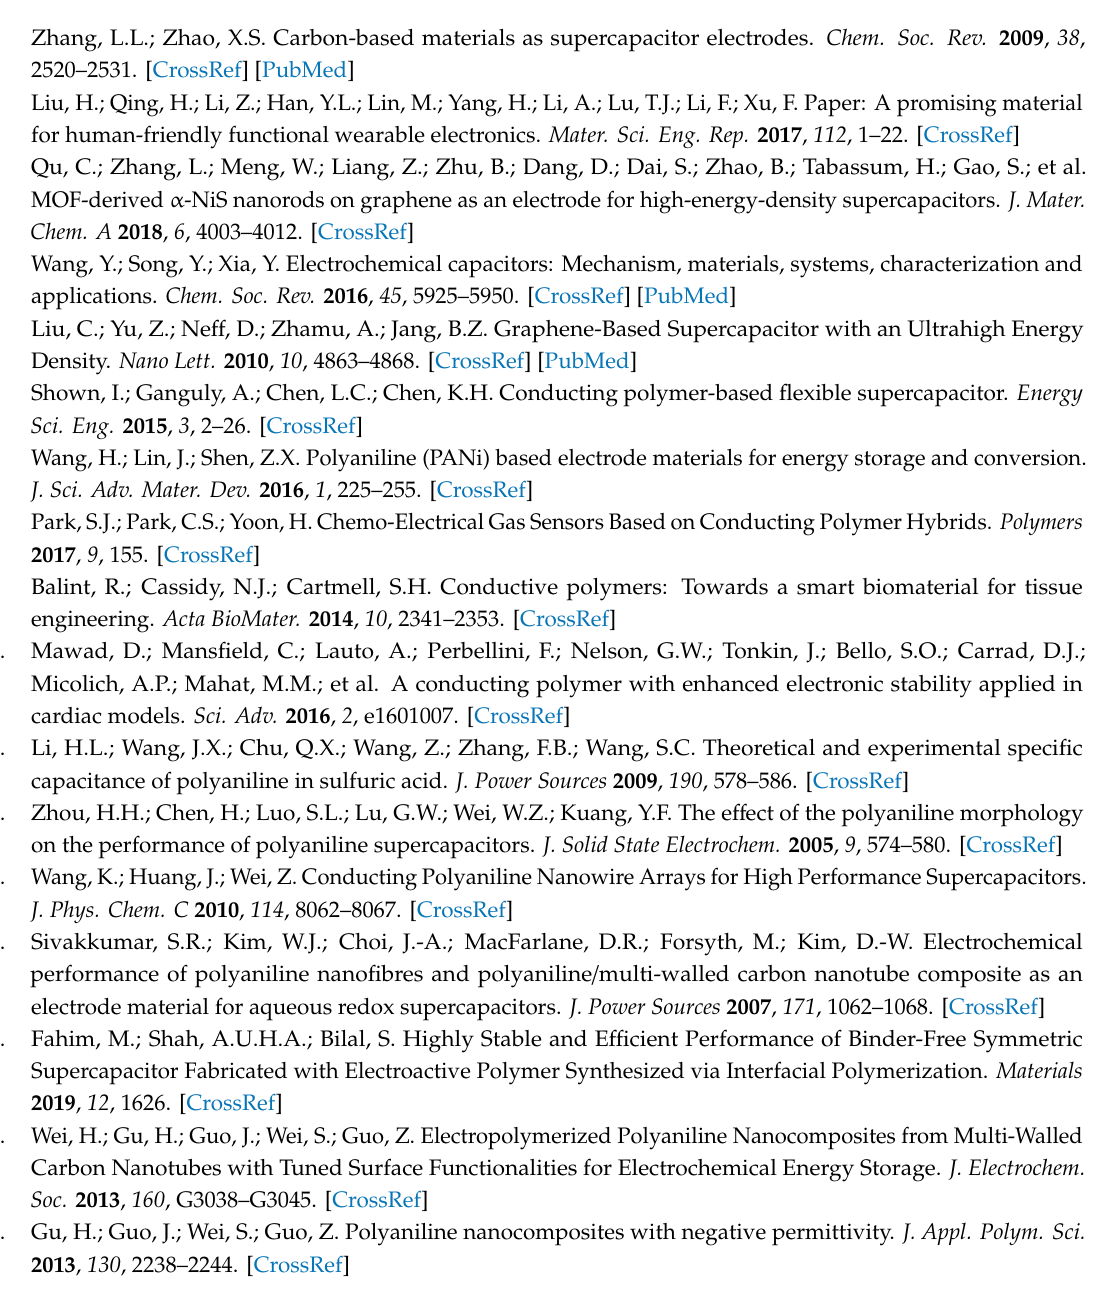
for polyaniline nanofibers with sodium phytate as dopant. Table S2: Comparison of the Specific Capacitance of PANI and PANI based materials in three-electrode